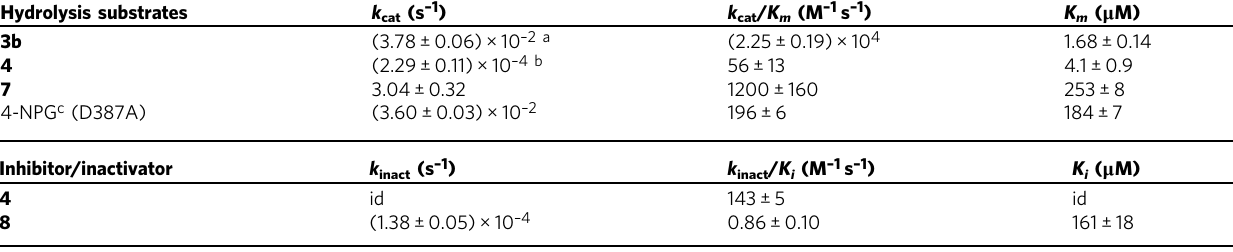
Conditions for all experiments were T = 37°C in 50mM HEPES buffer, pH 7.4, quoted errors (±) are the standard errors for the fi ts of kinetic data to either the Michaelis-Menten equation (all values except for inactivation by 4 ) or a linear equation id;indeterminable a k cat = (9.7±2.3)×10 – 2 s – 1 corrected value based on the inactivation data for 4 , which does not assume 100% activity b k cat = (5.9±1.3)×10 – 4 s – 1 calculated from the inactivation data for